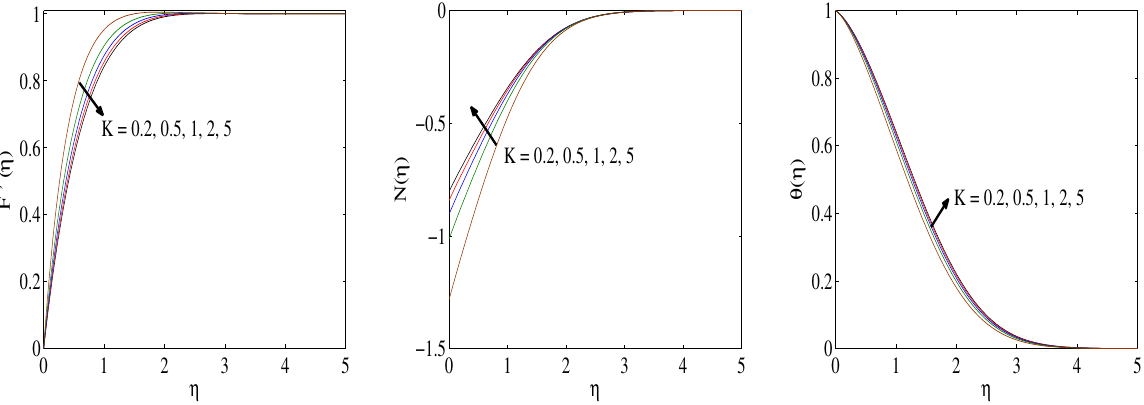
Figure 5. Velocity and angular velocity distribution under the impact of K factor.